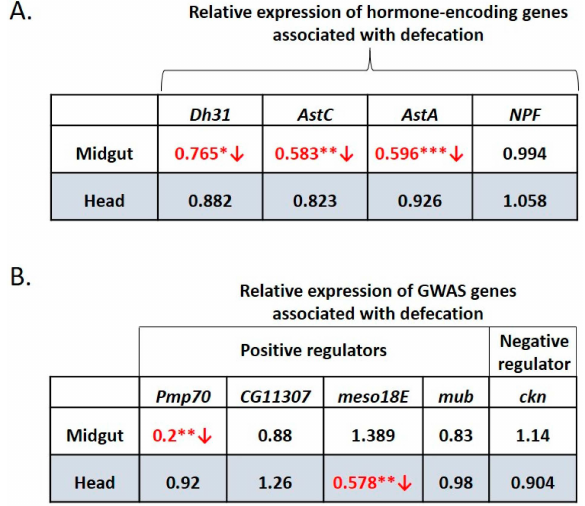
Figure 8. Starvation reduces expression of hormonal genes, Dh31 , AstC and AstA , and positive regulators, Pmp70 in the midgut, and meso18E in the head. Relative expression of ( A ) hormone- encoding genes Dh31 , AstA , AstC and NPF and ( B ) GWAS-identified positive ( Pmp70 , CG11307 , meso18E and mub ) and negative ( ckn ) regulators of the defecation rate, in midgut and head, upon starvation vs. feeding on 4% sucrose of female OR6 adults. Values indicated in red accompanied by a red arrow pointing down represent statistically significant decrease in the relative hormone gene expression. Each number represents the average of twelve values. Statistical significance using the t -test is indicated as * p < 0.05, ** p < 0.01 or *** p <